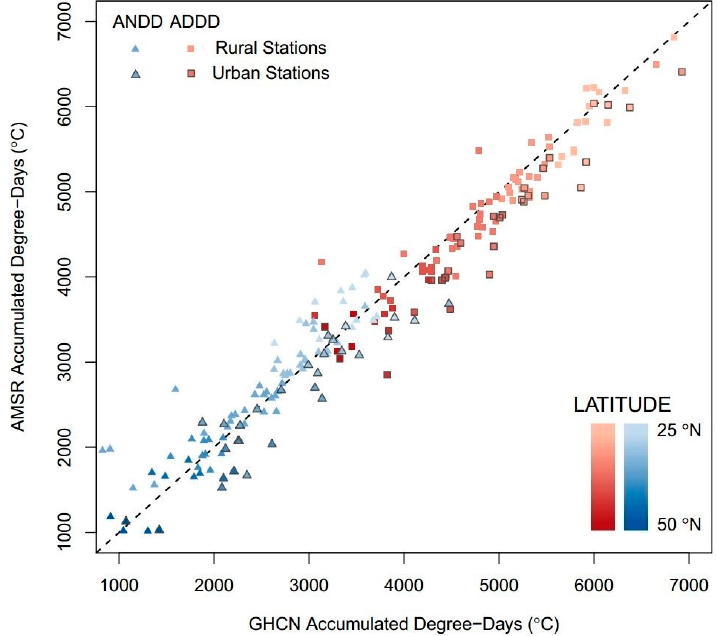
Figure 5. Comparison between thermal times calculated from Advanced Microwave Scanning Radiometers (AMSR) and Global Historical Climate Network (GHCN) data for North America. Accumulated diurnal and nocturnal degree-days are displayed as red squares and blue triangles, respectively. The 1:1 line is drawn across data space to aid comparison. Data points are shaded by the color ramp representing increases in the latitudes from 25° to 50°N.